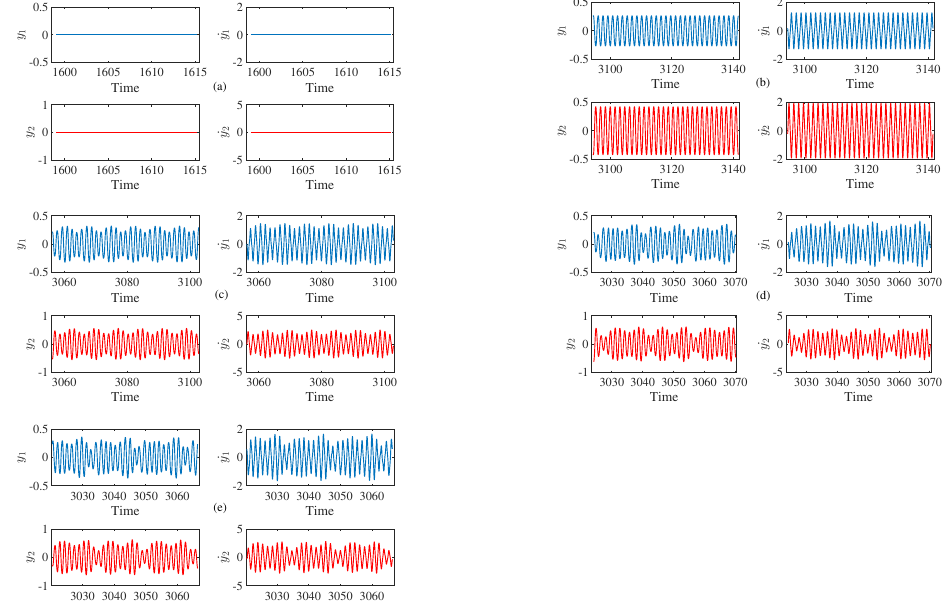
Figure 6. Time-Series waveforms of the considered system for different values of non-dimensional frequency, ω nd . In each of the figure, x -axis is the non-dimensional time and the y -axis is the non- dimensional displacements, y 1 and y 2 , and the non-dimensional velocities, ˙ y 1 , ˙ y 2 . The left and the right sides of the upper trace of each figure are the state-variables y 1 and ˙ y 1 respectively. The left and the right sides of the lower trace of each figure are the state-variables y 2 and ˙ y 2 respectively. ( a ) ω nd = 3.89, y 1 = y 2 = ˙ y 1 = ˙ y 2 = 0, i.e., fixed-point solutions, ( b ) ω nd = 4.00, Period-1 orbit, ( c ) ω nd = 4.05, quasi-periodic orbit, ( d ) ω nd = 4.093, quasi-periodic orbit, ( e ) ω nd = 4.098, chaotic orbit. The parameters are: ζ 1 = 0.0868, ζ 2 = 0.1036, t 1 = 0.2413, t 2 = 0.288, b 1 = 45.7143, b 2 = 54.5737, a 1 = 5.8548 × 10 − 3 , D 1 = 1.5, β = 11.11, µ = 1.1938, δ 1 = 1. The initial condition is chosen to ( 0.333,0,0,0 ) to obtain the time-series waveforms. (Color